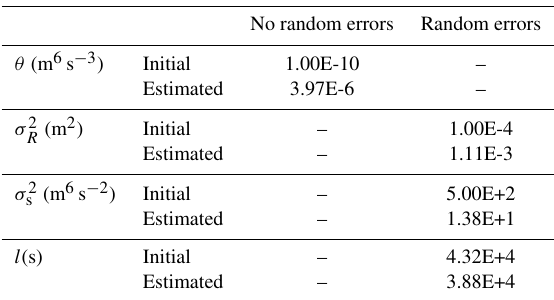
Table 3. Secchia River: initial and estimated structural parameters and epistemic error